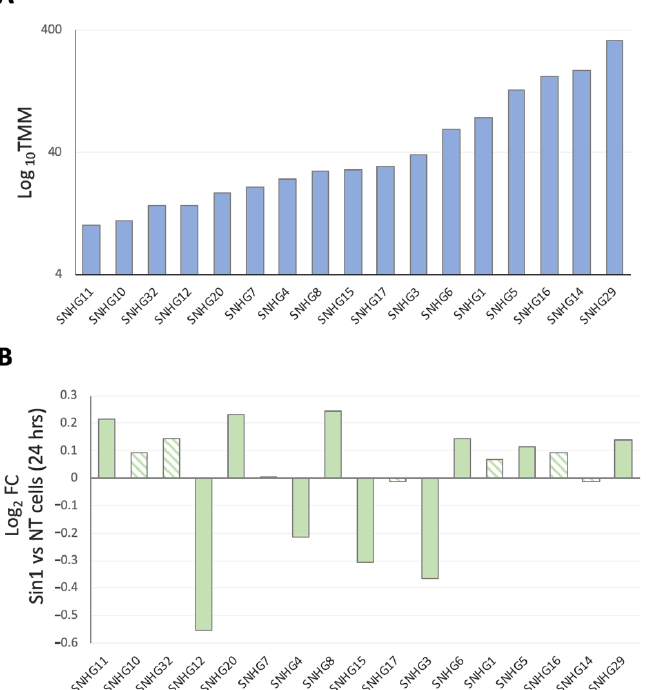
Figure 4. Expression of members of the small nucleolar RNA host genes (SNHGs). ( A ) Mean expres- sions (by log 10 TMM) of the 17 SNHG members identified by DE lncRNA analysis. ( B ) Fold changes (FCs) following treatment with 50 μ M Sin1 are shown for each of the SNHGs. FCs below and above zero show downregulated and upregulation of the indicated genes. Note that the values are logFC. Despite the small effect of the differential expression genes, the filled bar shows statistically signif- icant genes, and the striped bar indicates a gene belonging to the SNHG group, but failed to reach FDR ( p -value < 0.05).